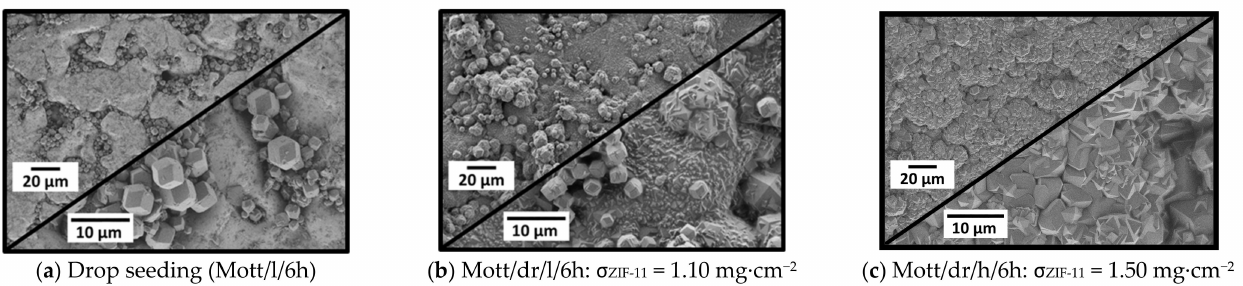
Figure 12. SEM images (500 × and 2000 × ) of stainless-steel supports ( a ) after drop seeding and after secondary growth, ( b ) with support placed on the bottom of the synthesis vessel, and ( c ) with the support hanging with seeded side downward. Secondary growth was performed in DEF for 6 h at 60 ◦